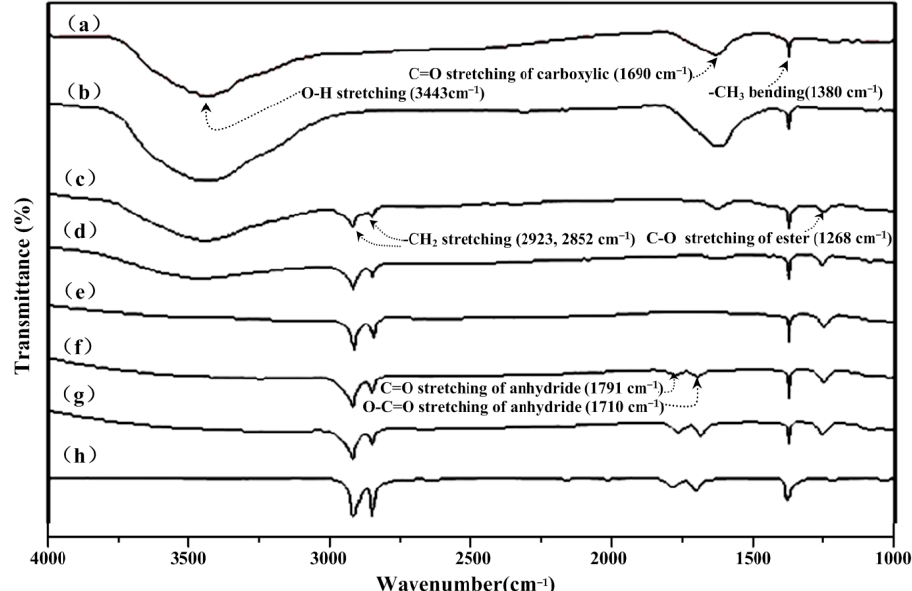
Figure 1. FT-IR spectra of ( a ) ANC, ( b ) ATANC, ( c ) FANC 5 , ( d ) FANC 10 , ( e ) FANC 12.5 , ( f ) FANC 15 , ( g ) FANC 20 , and ( h ) PE-g-MAH specimens. Figure 2 exhibits typical TEM micrographs of ANC, ATANC, and FANC x